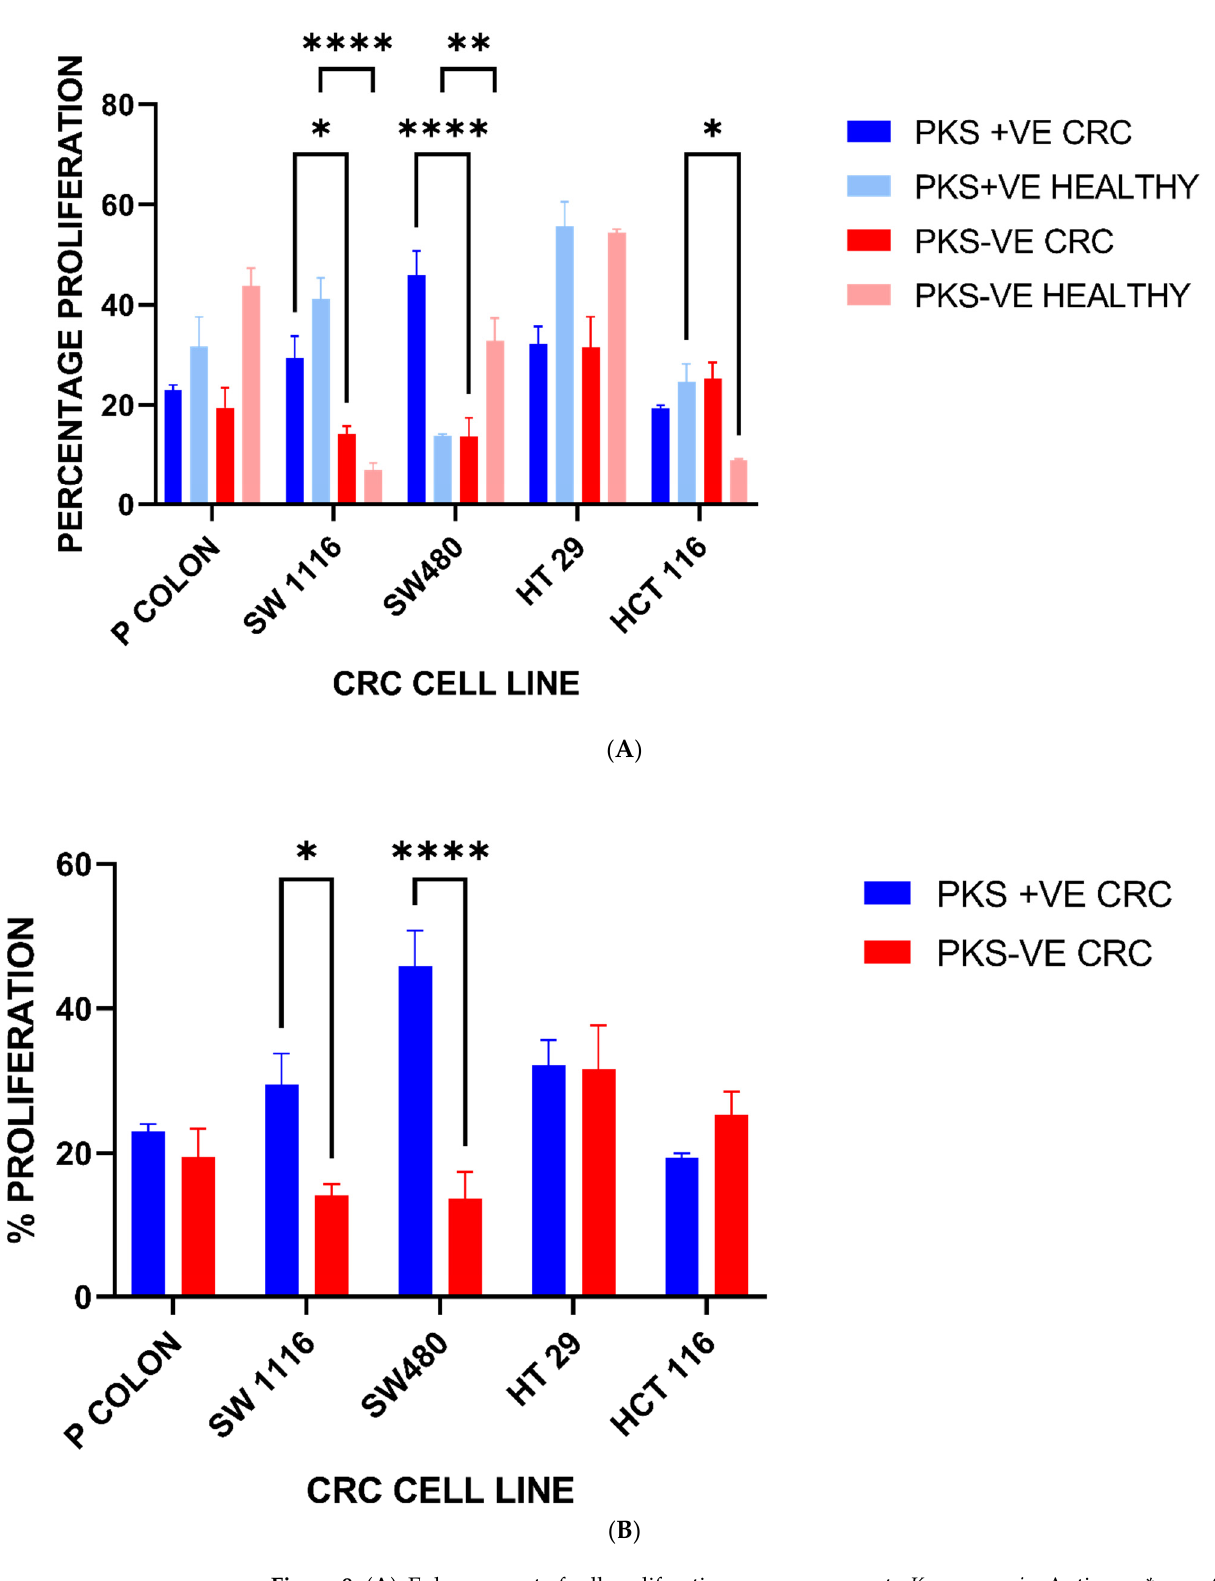
Figure 9. ( A ): Enhancement of cell proliferation upon exposure to K. pneumoniae Antigens, * = p < 0.05, ** = p < 0.01, **** = p < 0.0001. ( B ): Enhancement of cell proliferation upon exposure to K. pneumoniae antigens isolated from CRC patients * = p < 0.05, **** = p <